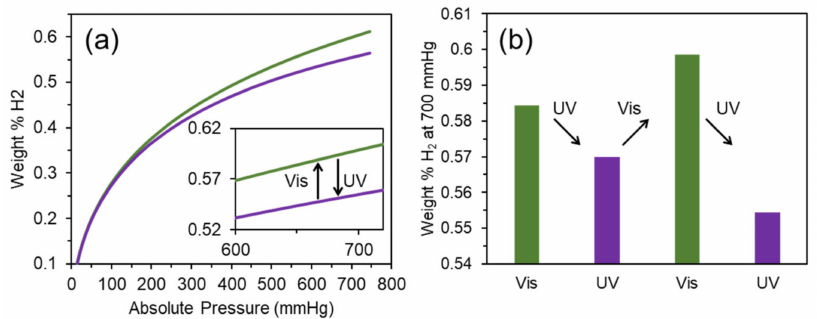
Figure 7. ( a ) Isotherms of hydrogen adsorption (77 K) for DAE-UiO-66 sample irradiated with visible light with a wavelength of 520 nm (green plot) and UV-light with a wavelength of 450 nm (violet plot). ( b ) Diagram of changing in H 2 capacity during sequential irradiation with visible light with a wavelength of 520 nm (green columns) and UV-light with a wavelength of 450 nm (violet columns).